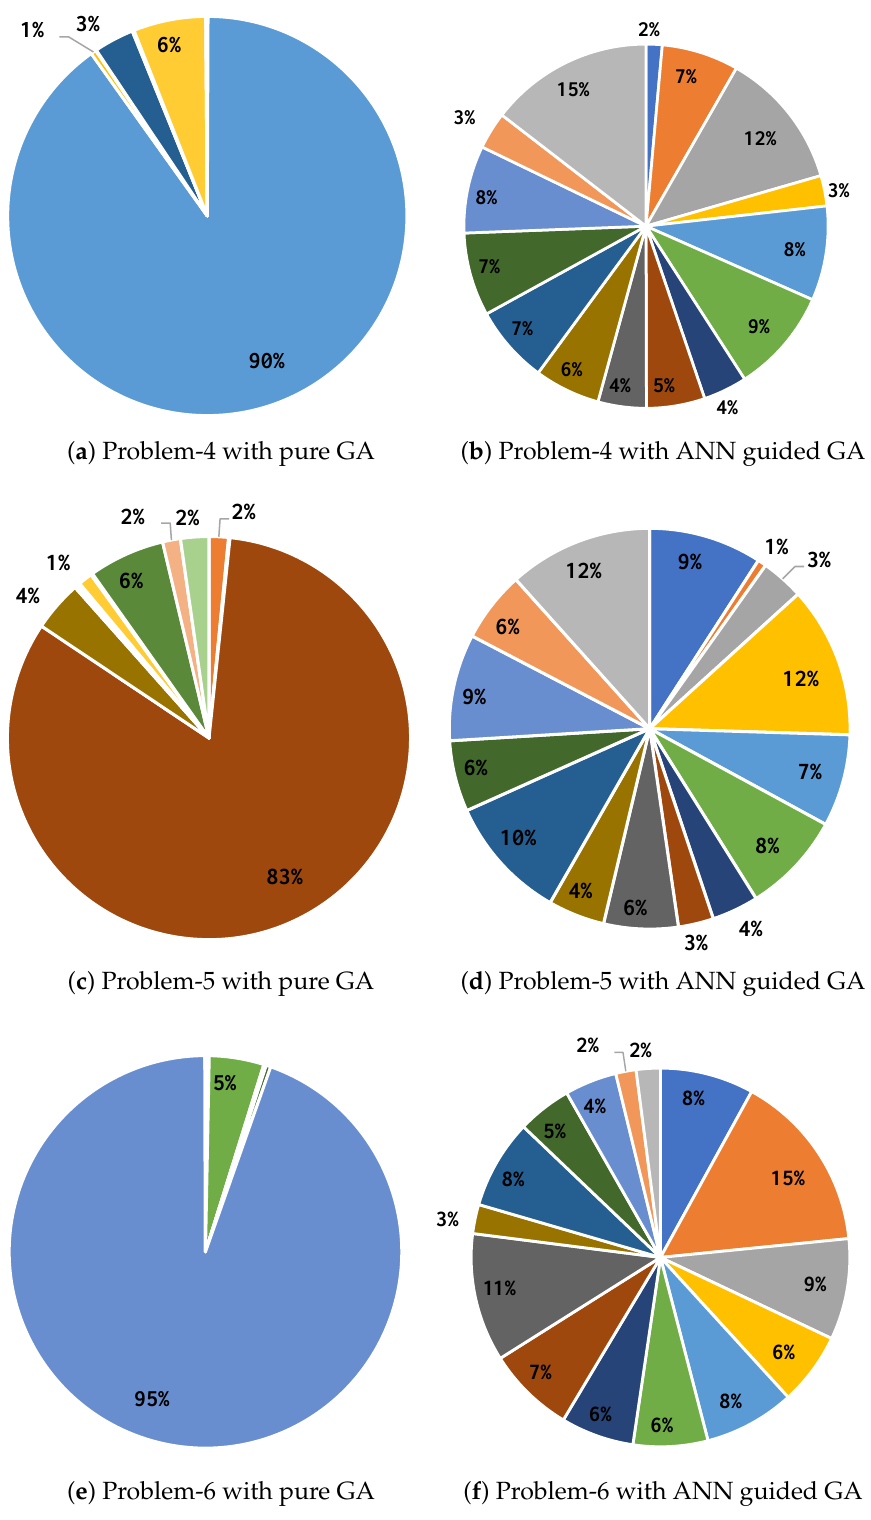
Figure 12. Allocation of population with and without ANN intervention. ( a , c , e ) are the results of pure GA and ( b , d , f ) are for ANN-guided GA, considering problems 4, 5, and 6, respectively, as mentioned in Table 7; the legends represent the cluster